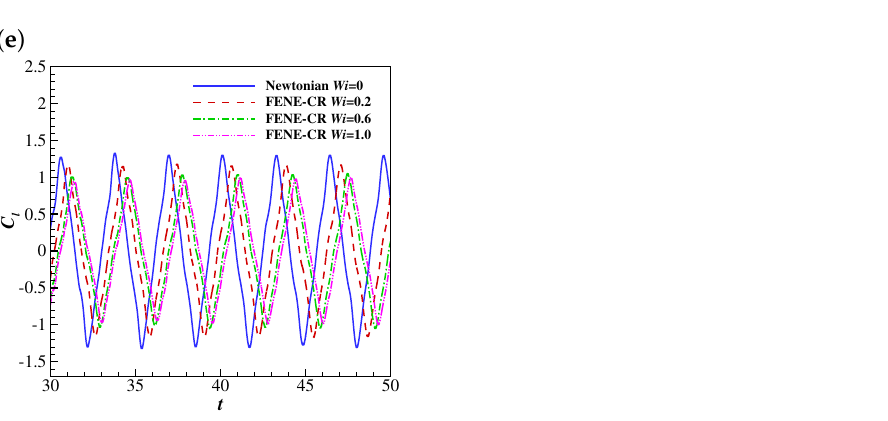
Figure 18. The time histories of the lift coefficient on the filament in Newtonian and FENE-CR uniform flows at Re = ( a ) 10, ( b ) 25, ( c ) 50, ( d ) 100 and ( e )